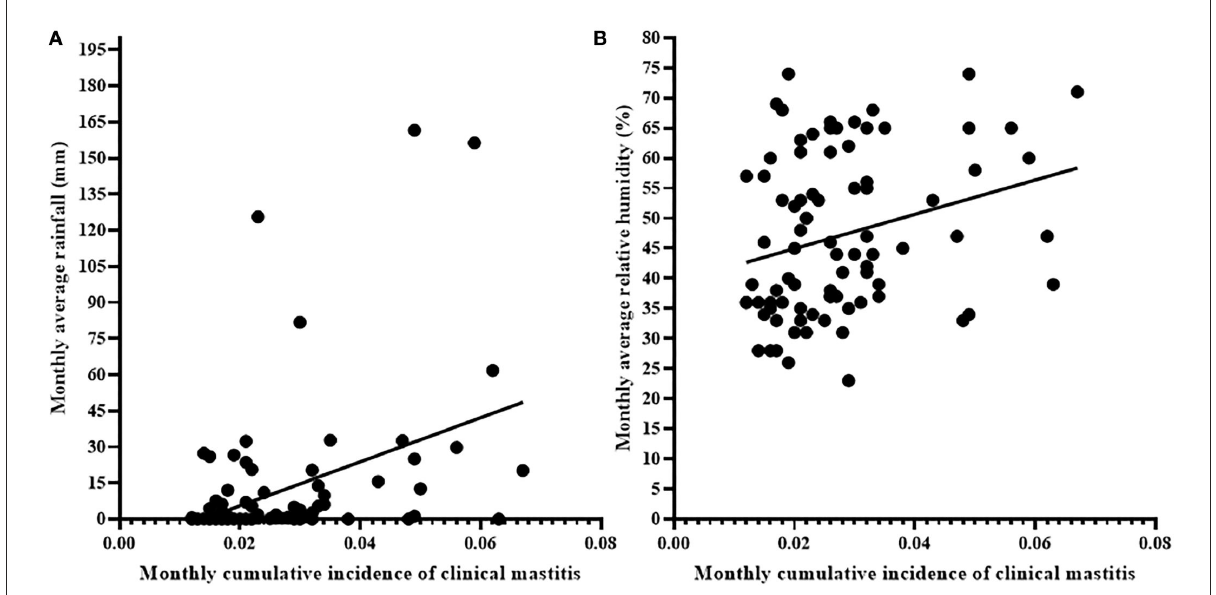
FIGURE3 Correlation of monthly cumulative incidence of clinical mastitis with monthly rainfall (A) and average monthly relative humidity (B) . Solid black circle represents an individual clinical mastitis case. There were association of monthly cumulative incidence of clinical mastitis to monthly rainfall ( r = 0.252, p < 0.05) and average monthly relative humidity ( r = 0.286, p < 0.01) recorded in the